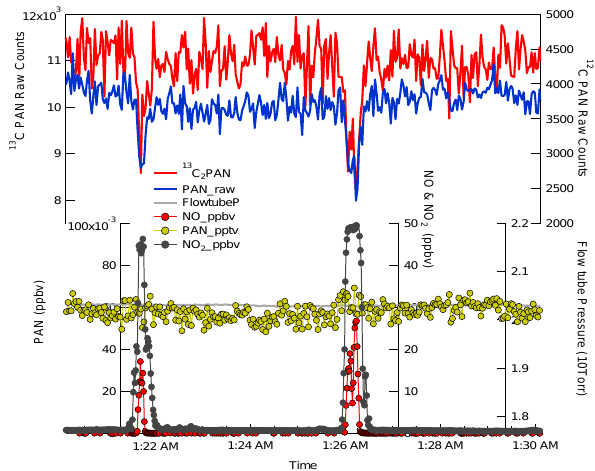
Fig. 13. Normalized sensitivity for PAN, PPN, PnBN and MPAN at low H 2 O mixing ratios as a function of water concentration in the flow tube.